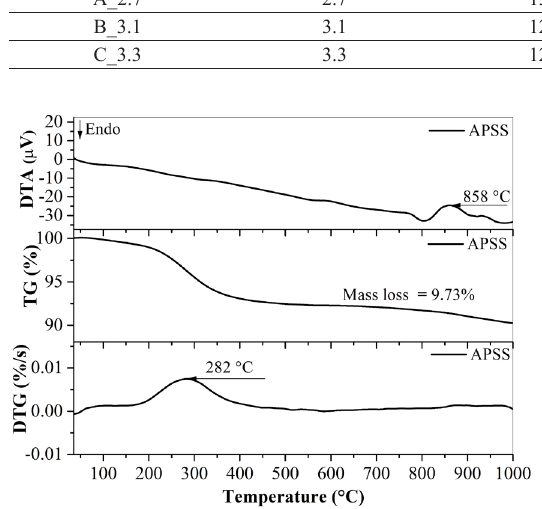
Figure 6. TG/DTG/DTA curves of APSS.